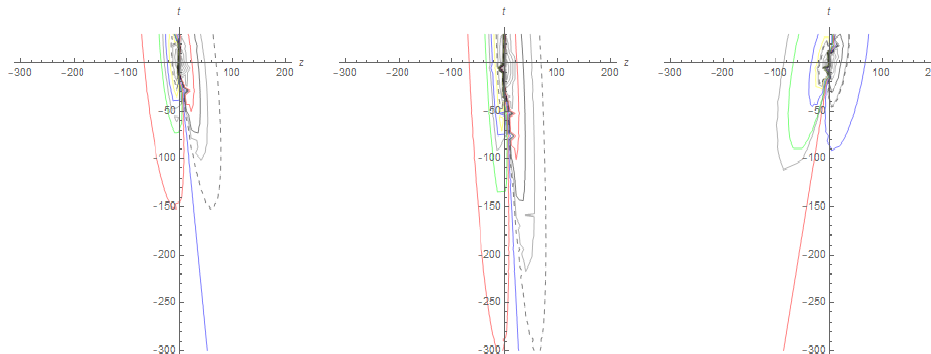
Figure 2. Contours graphs for Figure 1.